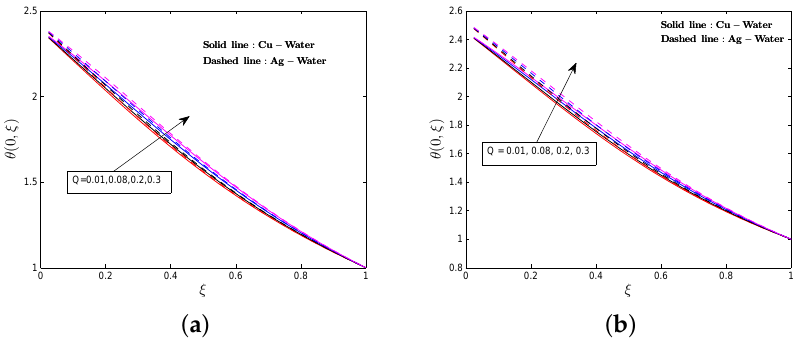
Figure 22. Surface temperature for various values of Q . ( a ) vertical plate; ( b ) horizontal plate.